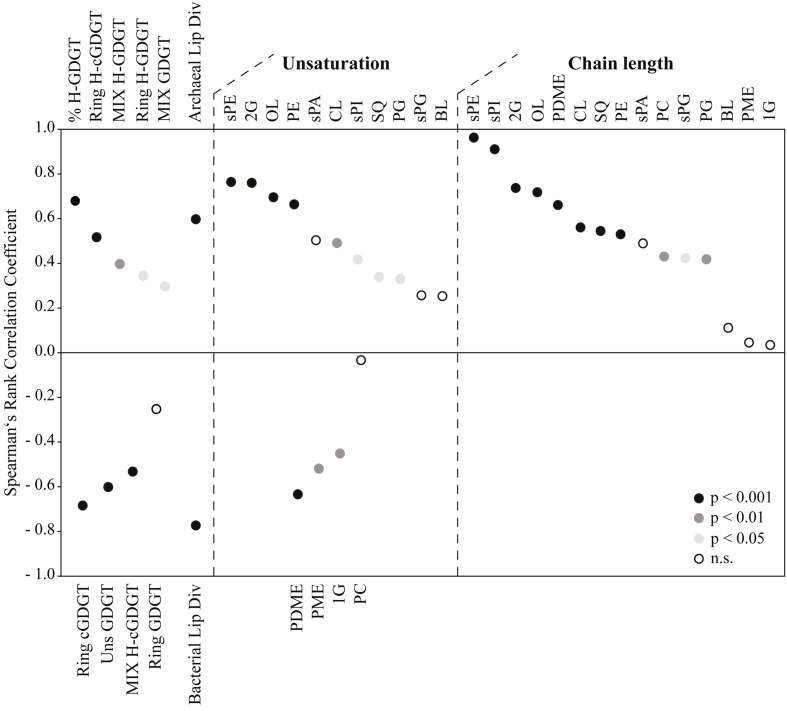
Analysis of molecular species of archaeal and non-archaeal lipids as a function of temperature. Spearman’s rank correlation coefficient values corresponding to positive or negative correlation (see Materials and Methods and Supplementary Table S2) between lipid parameters and temperature are displayed as circles, with colors indicating the level of significance (p < 0.001, p < 0.05, p < 0.01 or not significant, n.s.). Archaeal/Bacterial Lip Div, archaeal/bacterial lipid diversity. Please see Supporting Information for details about lipid parameters used as input to the correlation analysis.